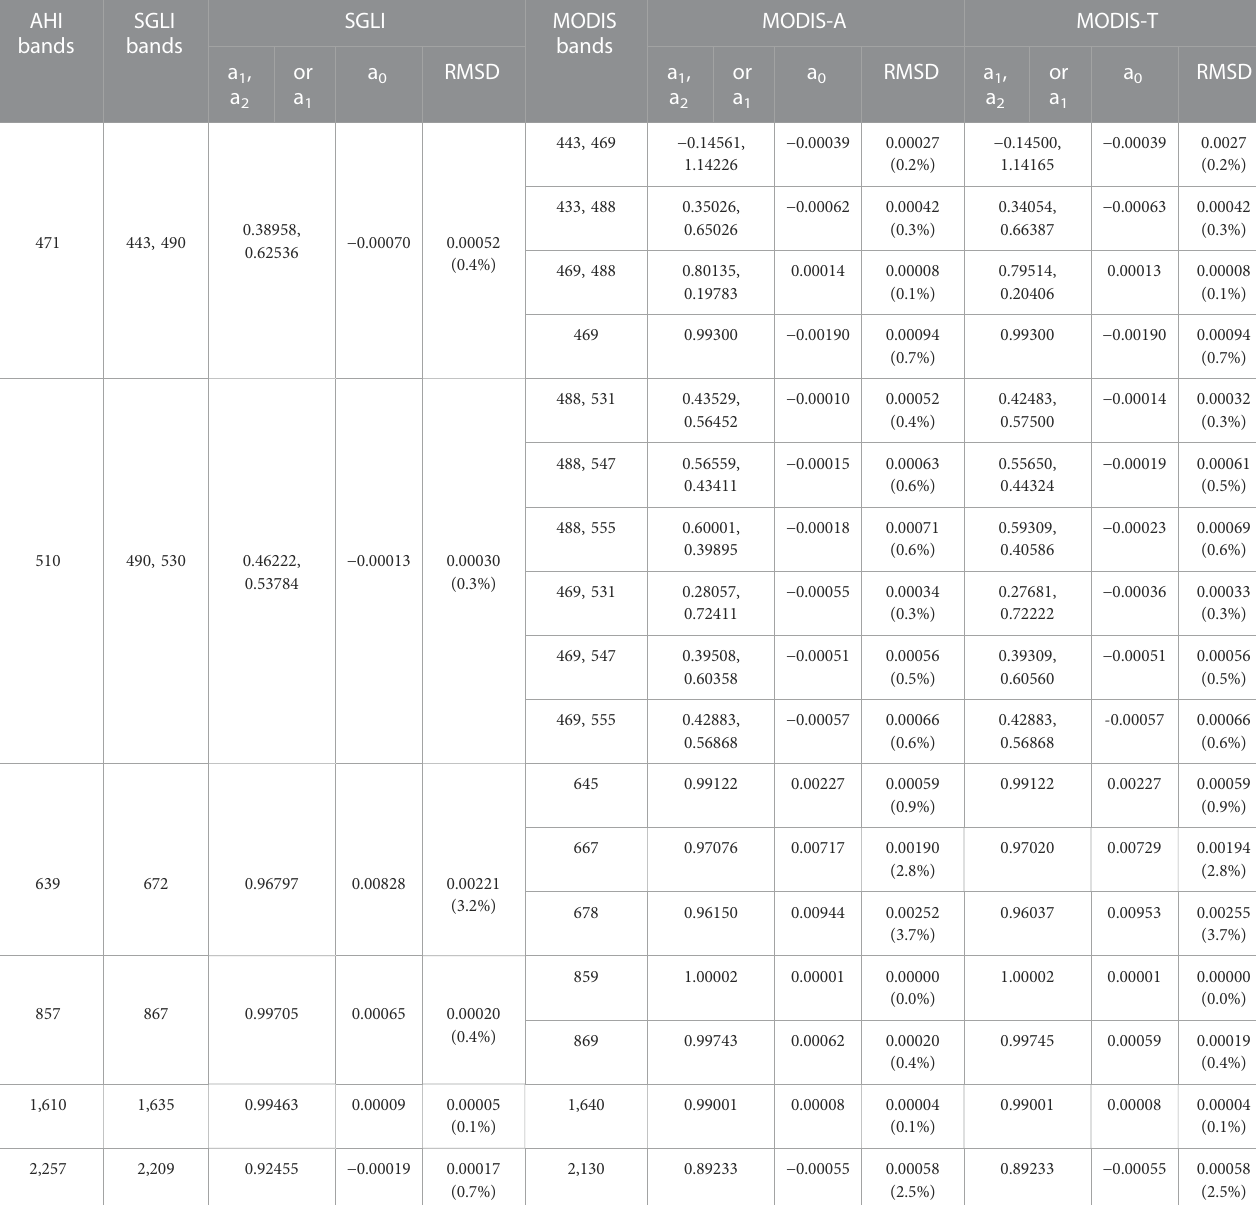
TABLE 2 The relations and corresponding RMSD for SGLI, MODIS-A, and -T band combinations to generate equivalent AHI bands, obtained using 6SV simulations with VZA ≤ 45 ° , SZA ≤ 60 ° , and no gaseous absorption (see main text for more details). TOA re fl ectance (denoted as ρ ) at each AHI band can be generated using a 0 +a 1 * ρ s,i + a 2 * ρ s,j or a 0 +a 1 * ρ s,i , where subscript s represents SGLI, MODIS-A, or MODIS-T, and i, j represents band i and j